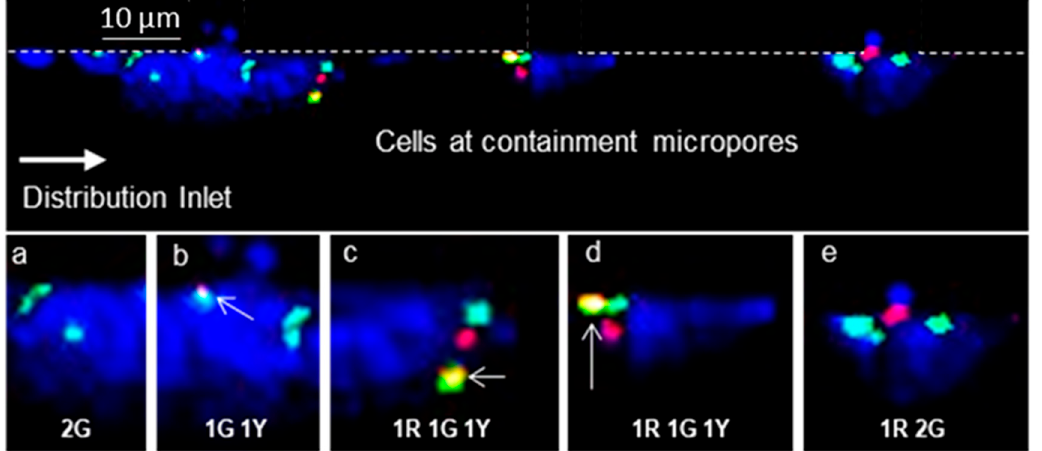
Figure 8. On-chip FISH processed B-cells isolated from a diagnosed B-ALL patient. TEL / AML1 FISH probes were used for the chromosomal aberration of t (12;21) translocation. Cells were imaged at the microtraps. Zoomed images show ( a ) single cell with 2 green FISH signals; ( b ) single cell with one green and one yellow signal; ( c ) a single cell with one red, one green, and one yellow FISH signal; ( d ) single cell with one red, one green, and one yellow FISH signals close to each other in the cell; and ( e ) single cell with one red and two green signals. In all cases, the images were collected using a 60 × objective with z-stacking.